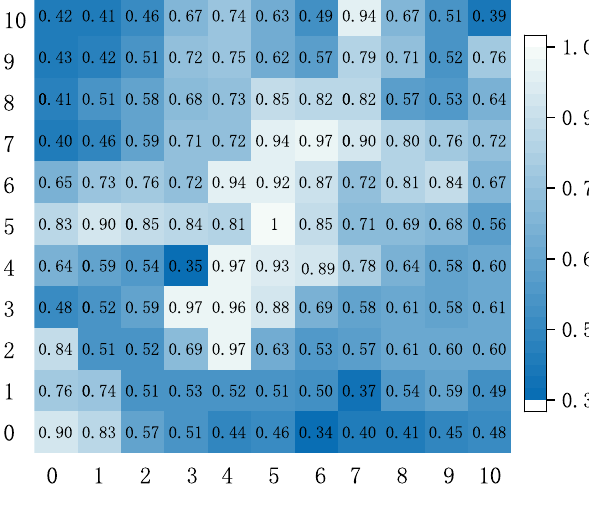
Figure 4. Spatial correlation